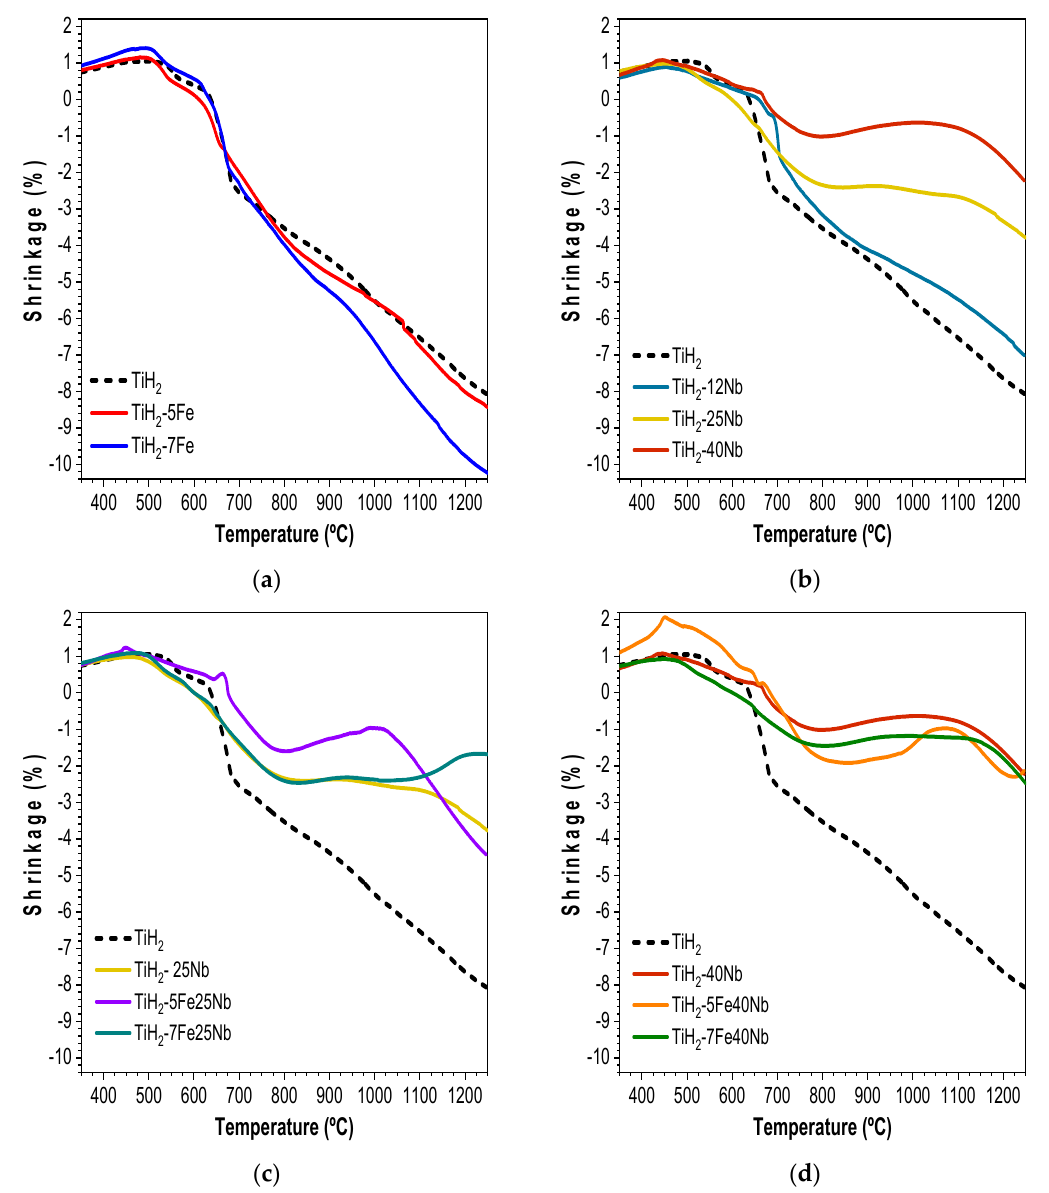
Figure 3. Dilatometric curves for compact powders. Analyses were performed under high-purity argon atmosphere, heating at 10 °C/min. ( a ) TiH 2 -Fe (5 and 7 wt. %); ( b ) TiH 2 -Nb (12, 25, 40 wt. %); ( c ) TiH 2 -Nb-Fe (25 wt. % Nb and 5, 7 wt. % Fe) and ( d ) TiH 2 -Nb-Fe (40 wt. % Nb and 5, 7 wt. % Fe). Samples with a lower amount of alloying elements (TiH 2 -5Fe, TiH 2 -7Fe, and TiH 2 -12Nb) presented similar shrinkage to unalloyed TiH 2 . As the content of alloying elements increased, shrinkage was considerably modified as compared to pure TiH 2